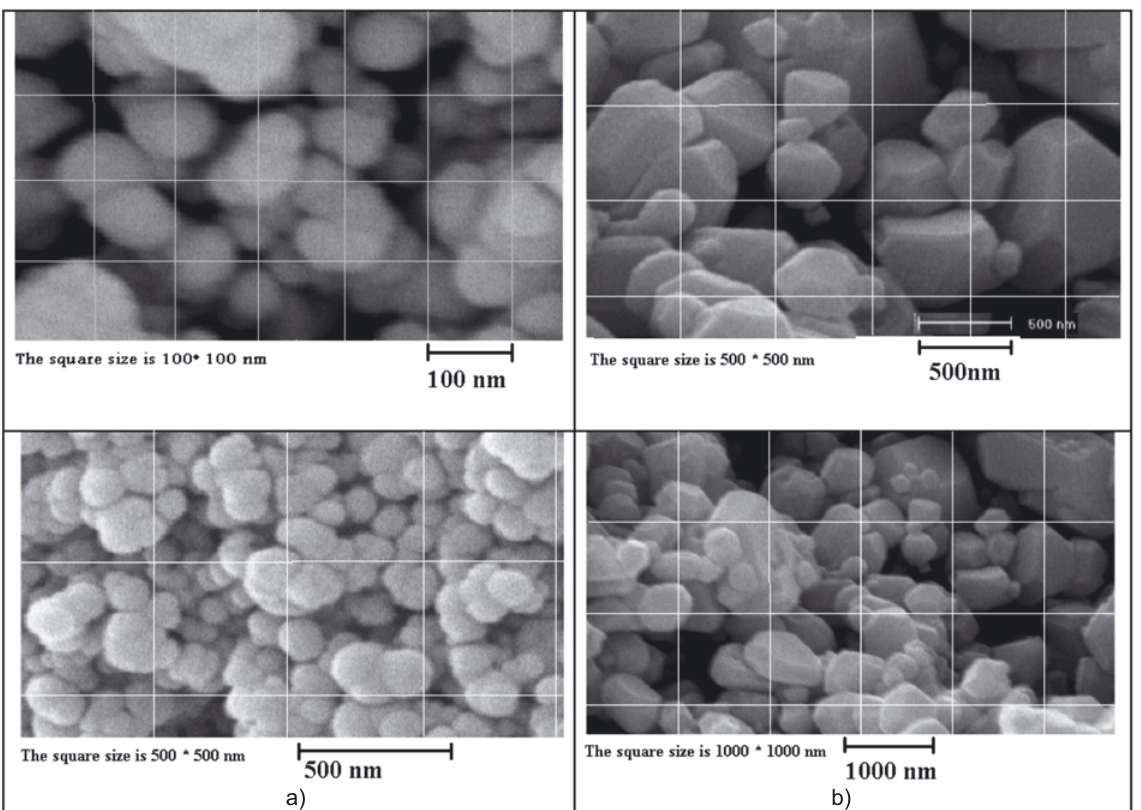
Figure 1. SEM micrographs at different magnifications (as indicated by the scale bar) of (a) electrosynthesised basic copper carbonate (with 70 nm average particle size) and (b) conventional prepared microparticles of basic copper carbonate (with 1 micron average particle